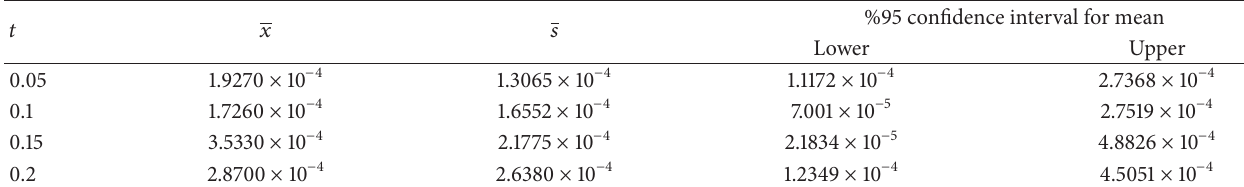
Table 3: Mean, standard deviation, and confidence interval for numerical solution mean ( 𝑇 = 0.25 , 𝐻 = 9/10 ).